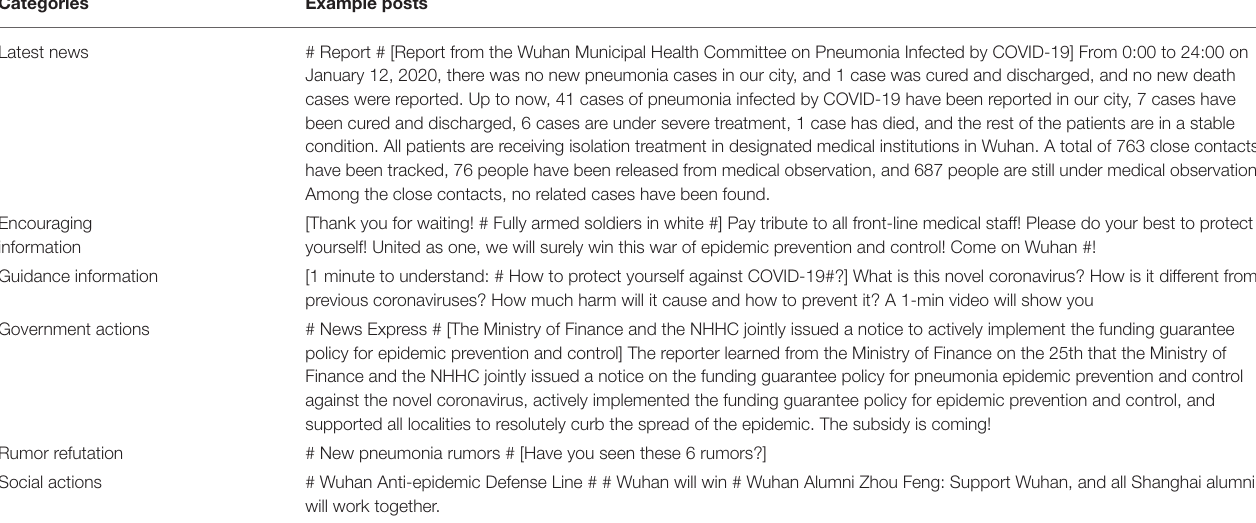
TABLE 1 | Content type of posts and example